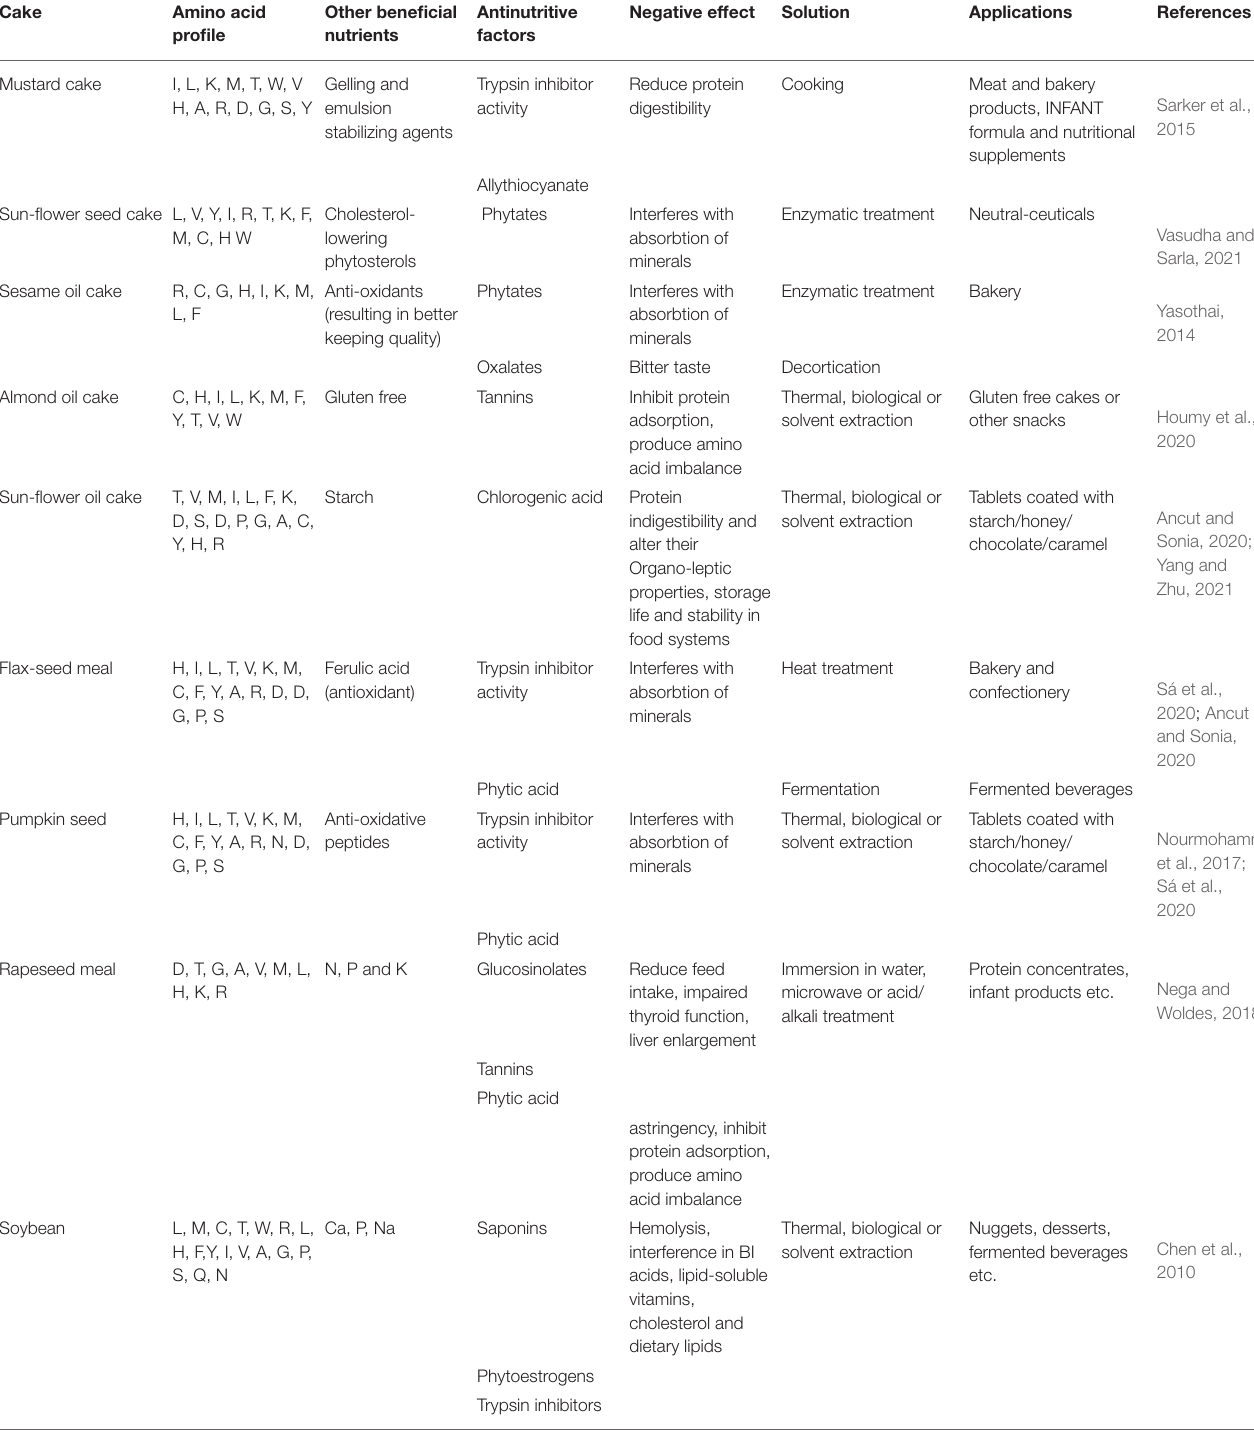
TABLE 3 | Benefits of protein from oilseed cake on food